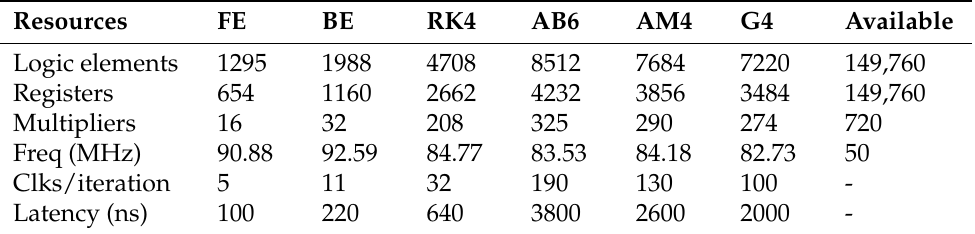
Table 7. Hardware resources for CO1 using FPGA Cyclone IV and applying different methods.